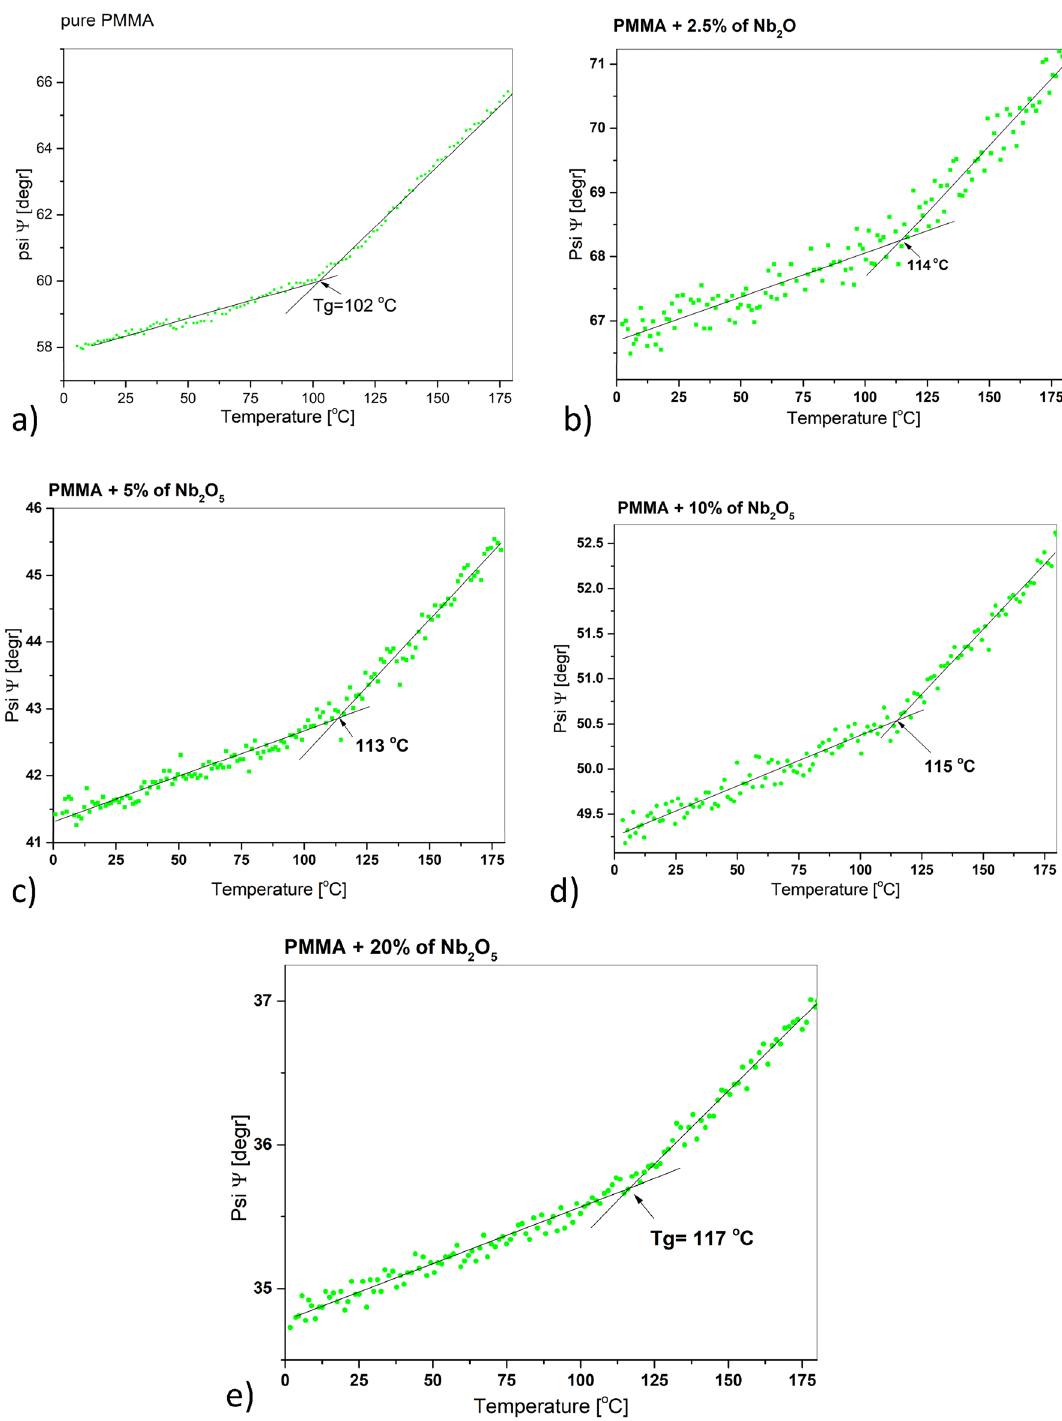
Figure 5. Ellipsometric angle Ψ at 900 nm as a function of temperature for: ( a ) pure PMMA, ( b ) PMMA/